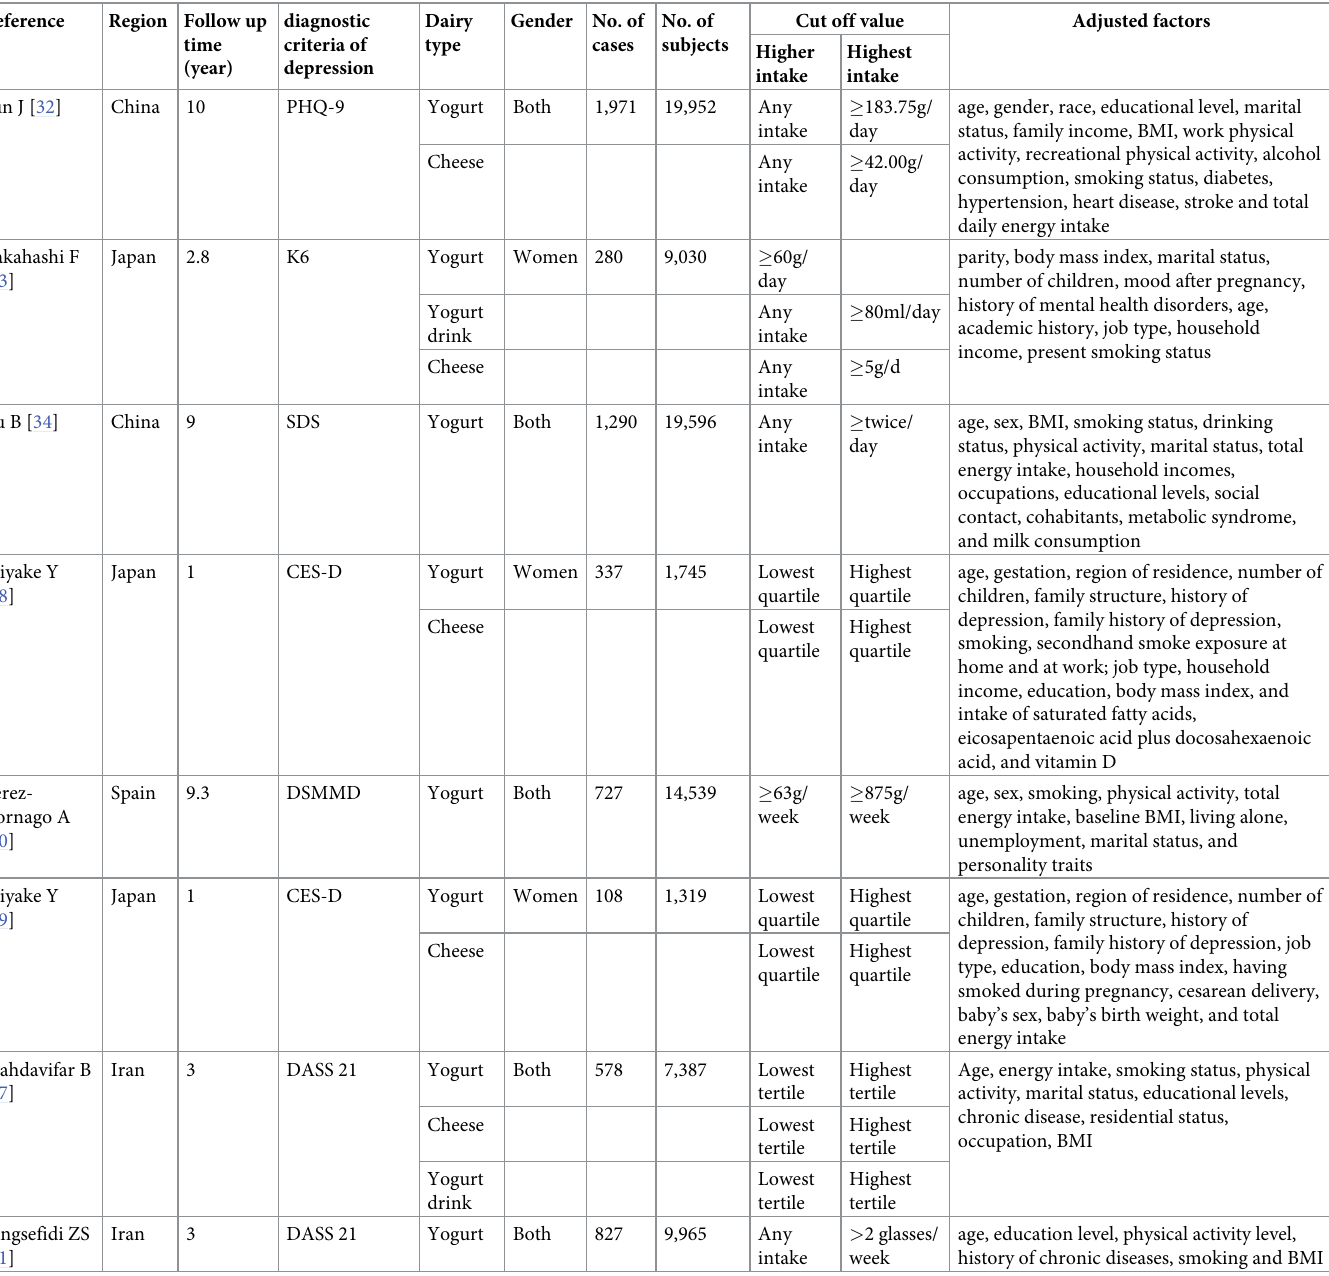
Table 1. Characteristics of literatures included in the